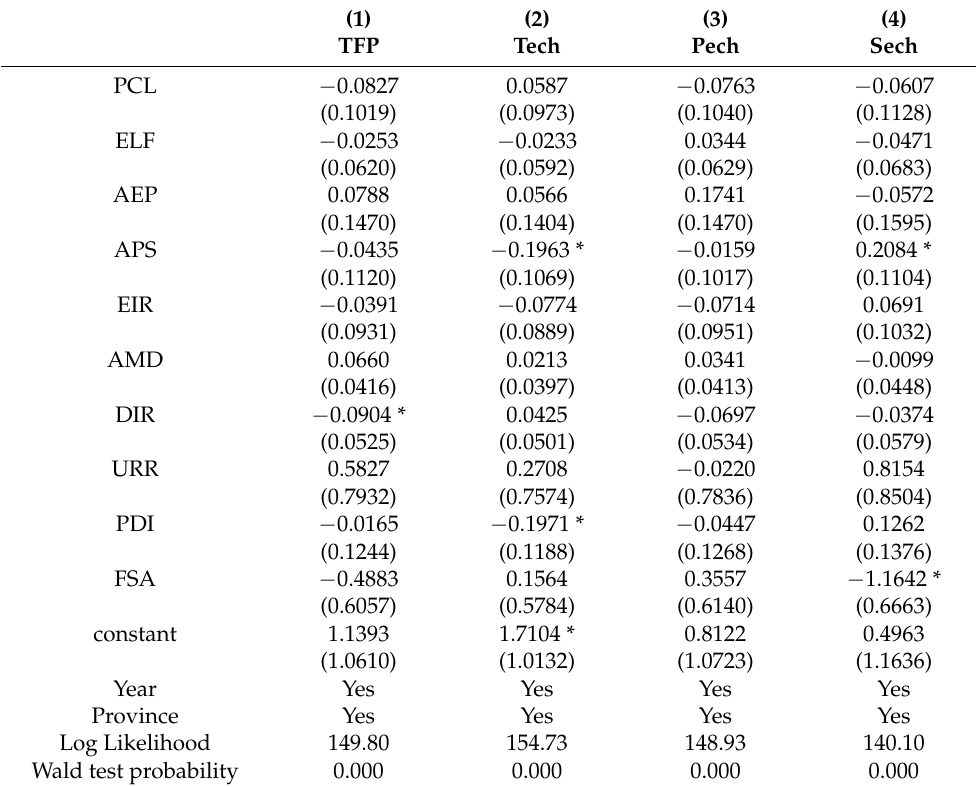
Table 7. Factors Influencing the Production Efficiency of Early Indica Rice and Its Decomposition